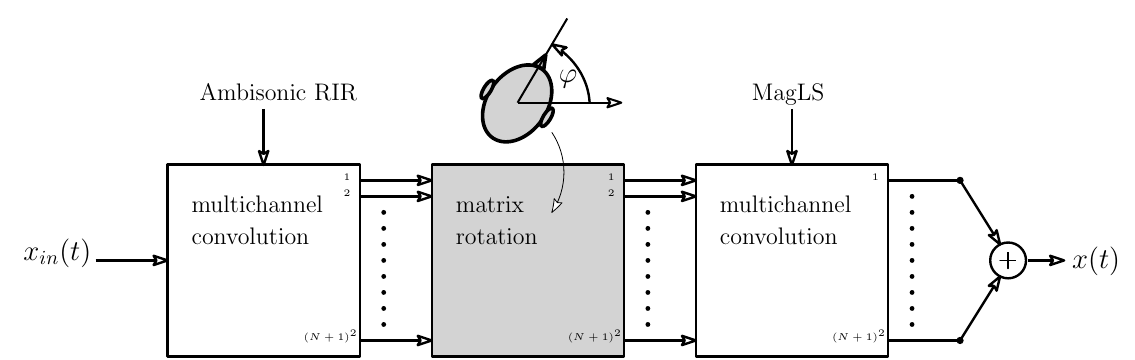
Figure 4. Block diagram of binaural rendering with measured Ambisonic RIRs (ARIRs). Here, MagLS refers to a state-of-the art Ambisonic binaural